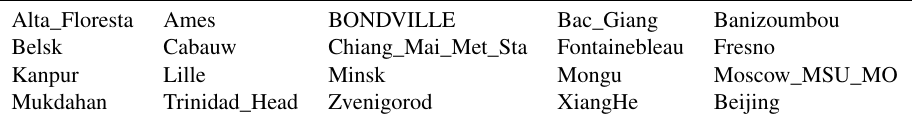
Table 7. AERONET stations for validation of PARASOL